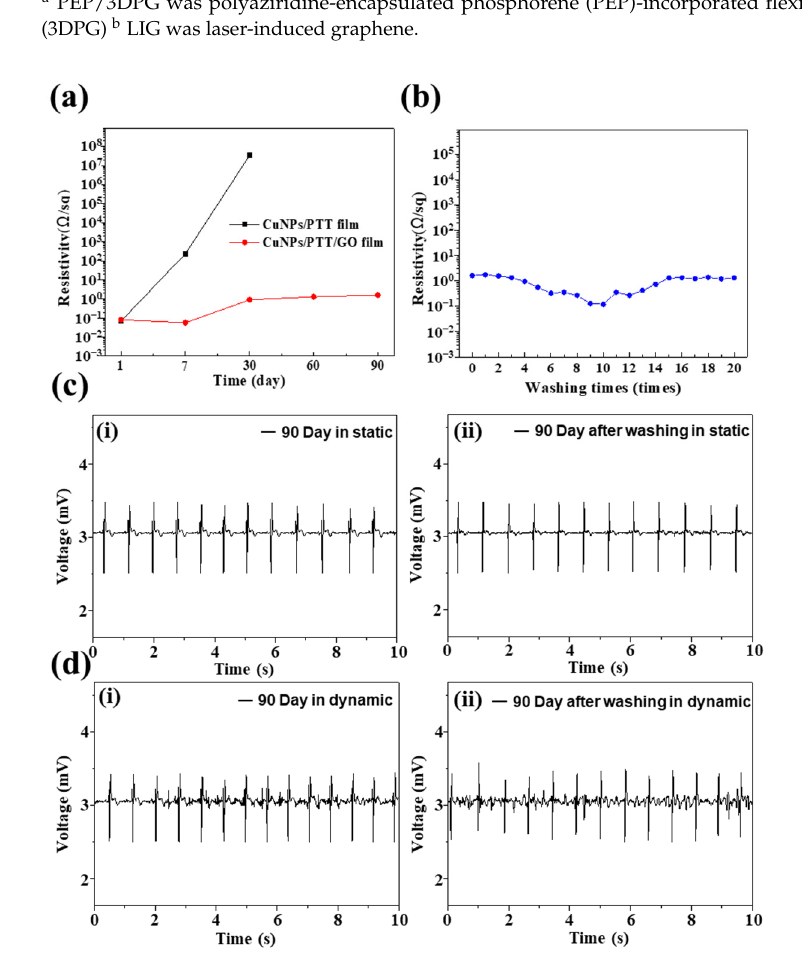
Figure 7. ( a ) The resistance values of CuNPs/PTT film and CuNPs/PTT/GO film for different days, ( b ) The resistance value of CuNPs/PTT/GO film after different times of washing test. ( c ) Static ECG and ( d ) Dynamic ECG signals where (i) before washing test and (ii) after 20 times wash cycles of CuNPs/PTT/GO film electrodes, respectively. Table 2. Performance comparison of present hybrid films with those reported in the literature.